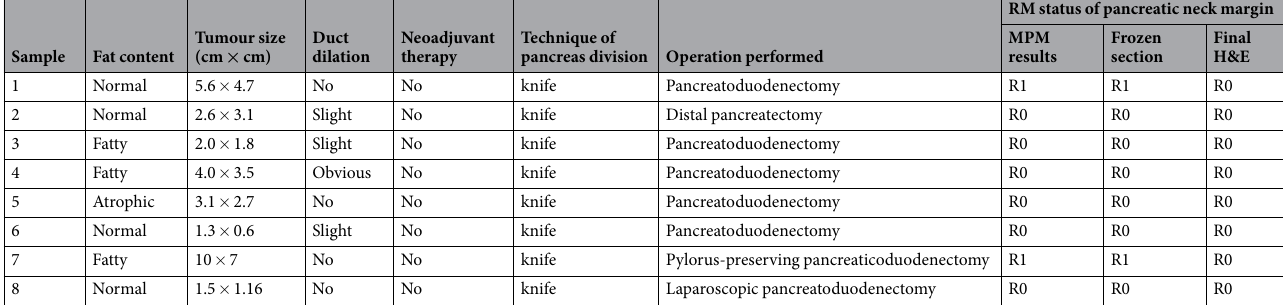
Table 3. Clinical characteristics of specimens and RM status of pancreatic neck margin, as inferred from MPM results, frozen sections and final H&E results.